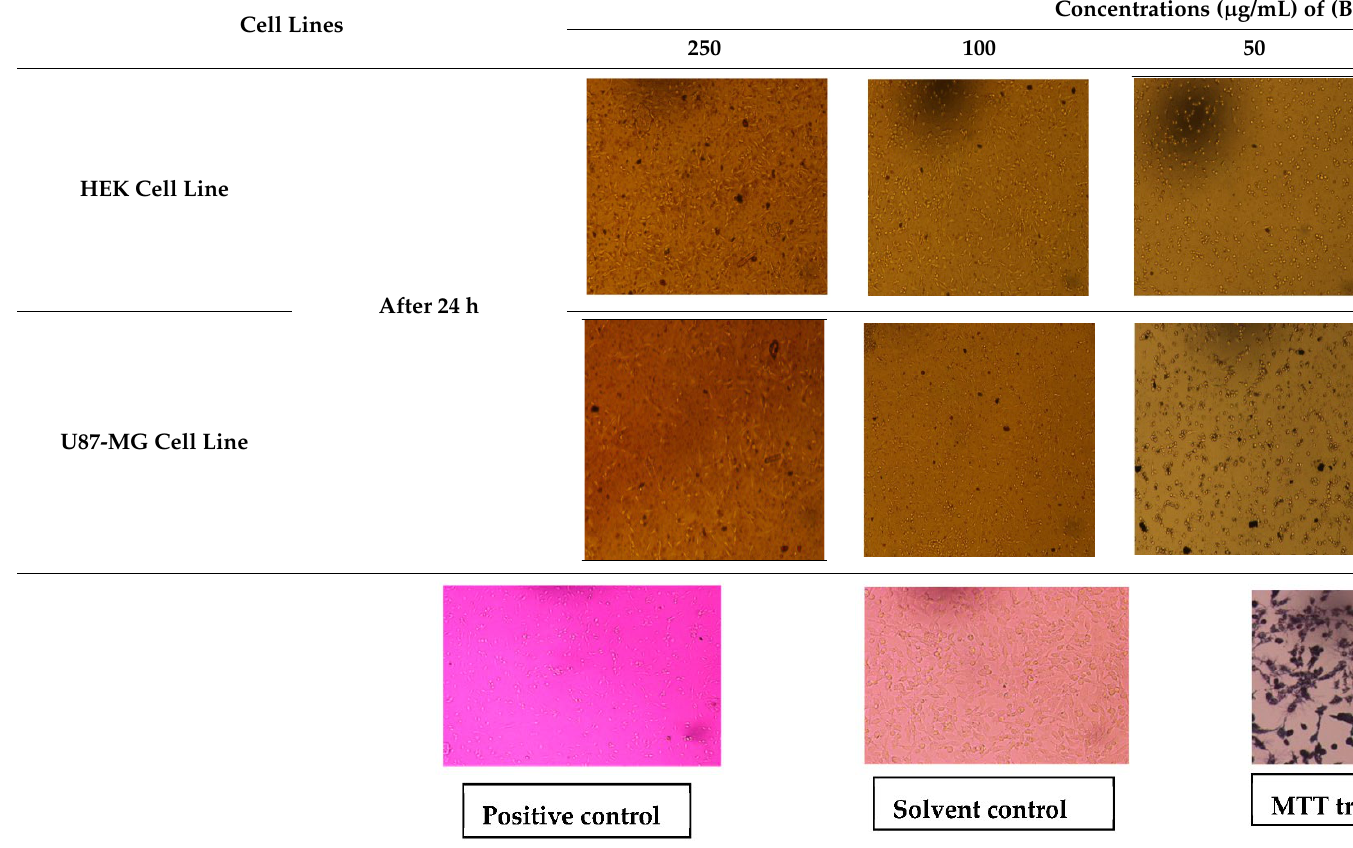
Table 5. Effect of biosynthesized silver nanoparticles on cell morphology of U87 and HEK293 cell lines.